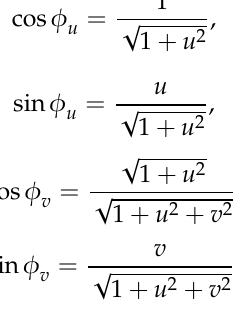
Figure 7. Images after homographic transformation, H , which moves the object origin point to the point (0,0,1) . 4 Examples of images after the transformation can be found in ( a – d )